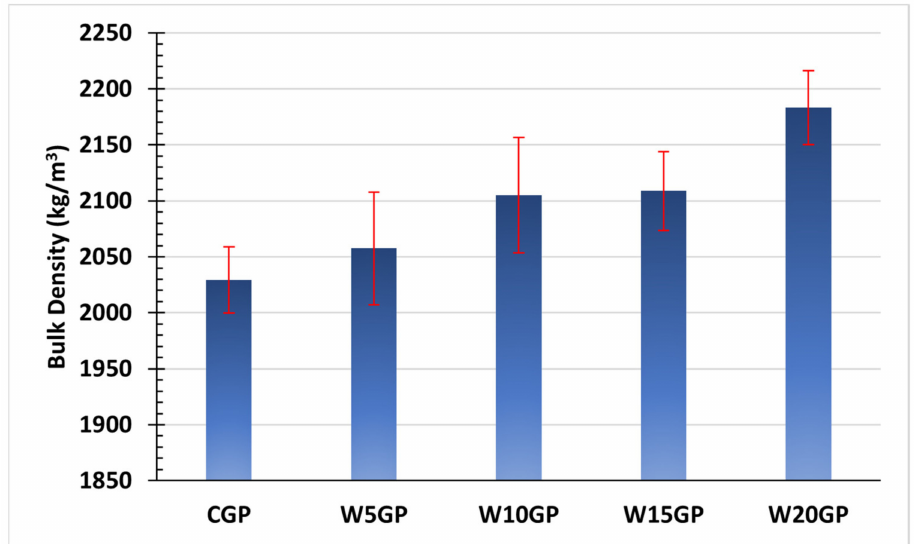
Figure 2. Bulk density of 8M NaOH, SS/SH of 1.00 (curing temperature of 60 ◦